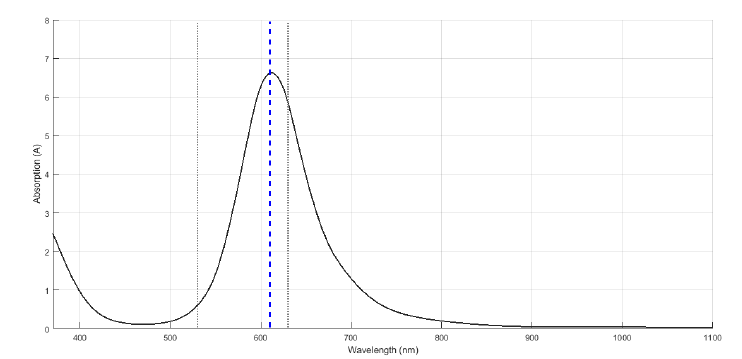
Figure A1. Spectrum obtained from the spectrophotometer and the artificial blood. The maximum absorbance was obtained with a wavelength of 610 nm.